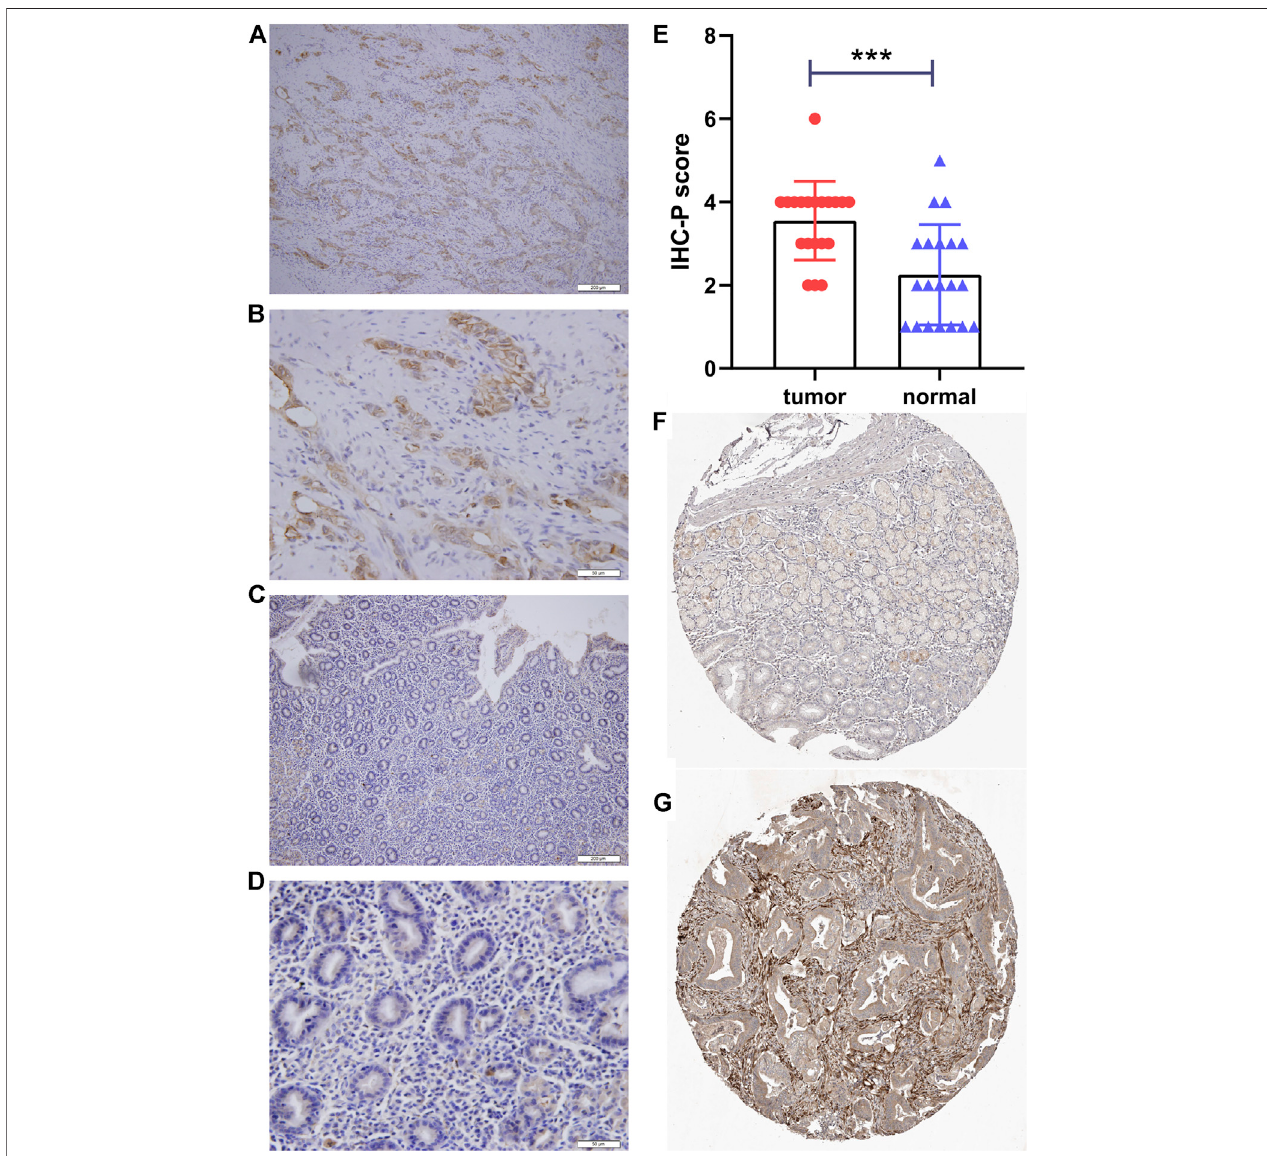
FIGURE 6 | Immunohistochemical staining of PLOD2 . (A) gastric cancer, ×10. (B) gastric cancer, ×40. (C) adjacent tissue, ×10. (D) adjacent tissue, ×40. (E) Statisticalanalysisofcancerandadjacenttissue. (F) validationtheexpressionofPLOD2innormaltissues(PatientID1650,staininglow)intheHumanProteinAtlas(HPA) database (G) validation the expression of PLOD2 in STAD (Patient ID 2557, staining medium) in the HPA database *** p <